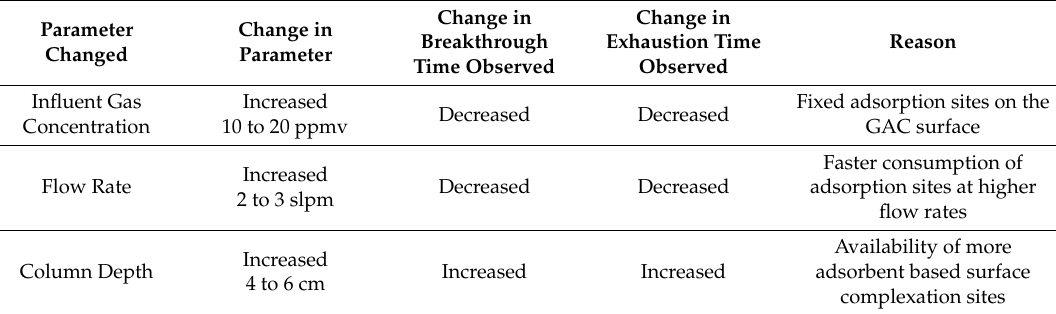
Table 4. Summarized e ff ects of operating parameters on to toluene adsorption e ffi ciency. Change in Change in Parameter Change in Breakthrough Exhaustion Changed Parameter Time Observed